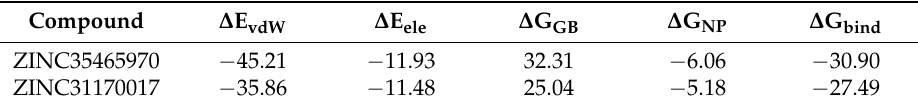
Table 5. Energy contributions to the free energy binding